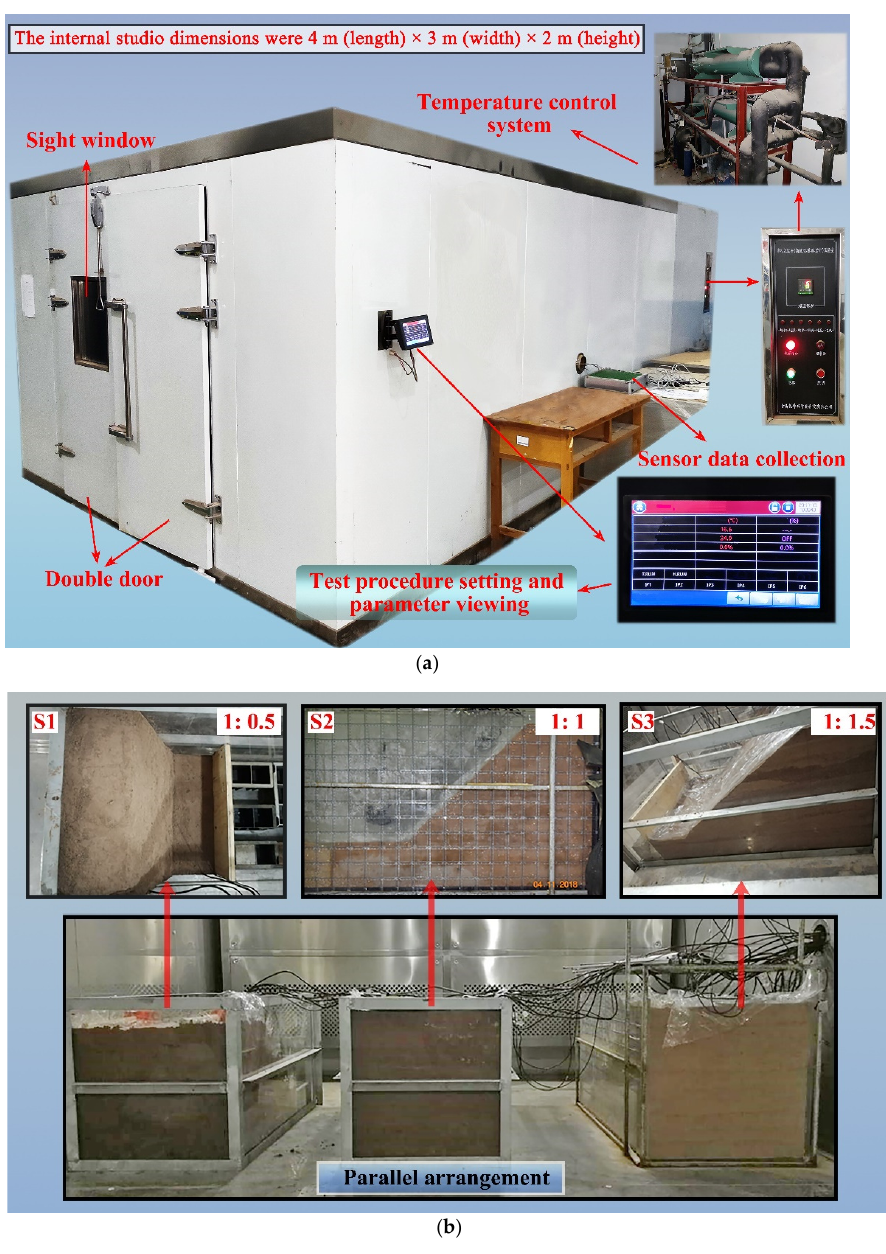
Figure 4. Custom-fabricated environmental chamber. ( a ) Freeze–thaw environmental chamber, test temperature range: − 30 to 80 °C, temperature change accuracy: ±0.1 °C, heating rate is 3 °C/min, temperature range: − 30 to 80 ◦ C, temperature change accuracy: ± 0.1 ◦ C, heating rate is 3 ◦ C/min, cooling rate is 1 ◦ C/min; ( b ) slopes are arranged parallel in the test, and the ratio of three groups of slopes is different. slopes is